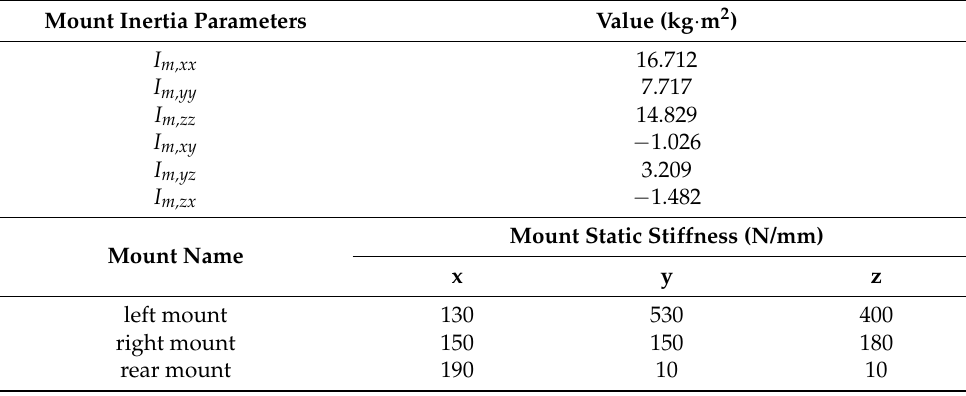
Table A2. Powertrain mounting system parameters.